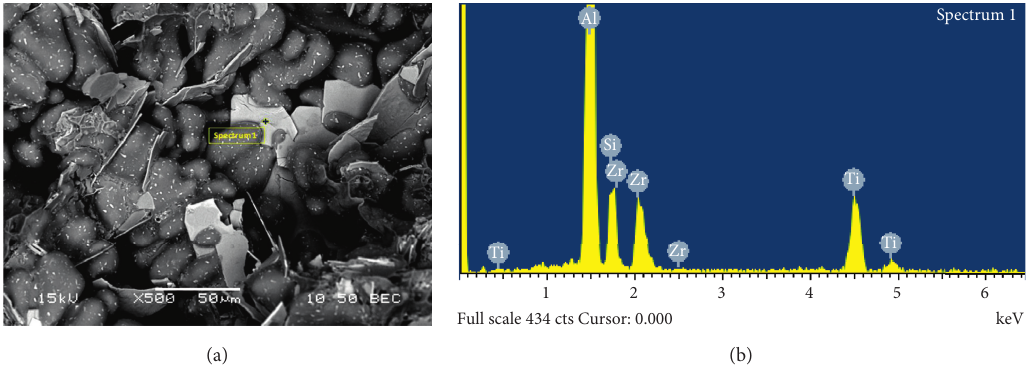
Figure 11: (a) BSE image of T6-treated M3S alloy after stabilization at 250 ° C for 200 hours showing the distribution of coarsened precipitates and Al-Si-Ti-Zr thin plates and (b) EDS spectrum corresponding to the Al-Si-Ti-Zr plates observed in (a).